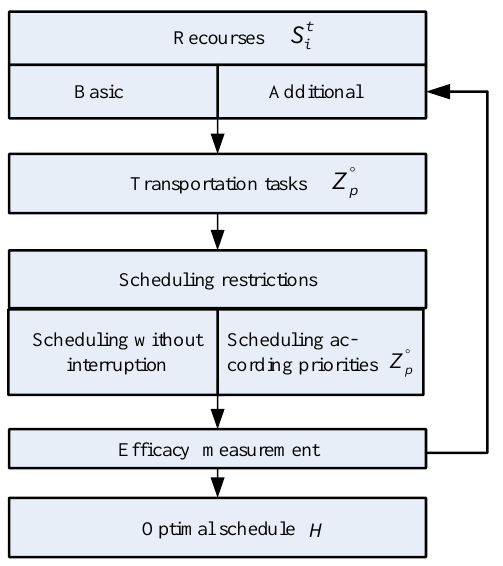
Fig. 4 . General sequence model structure of public transport